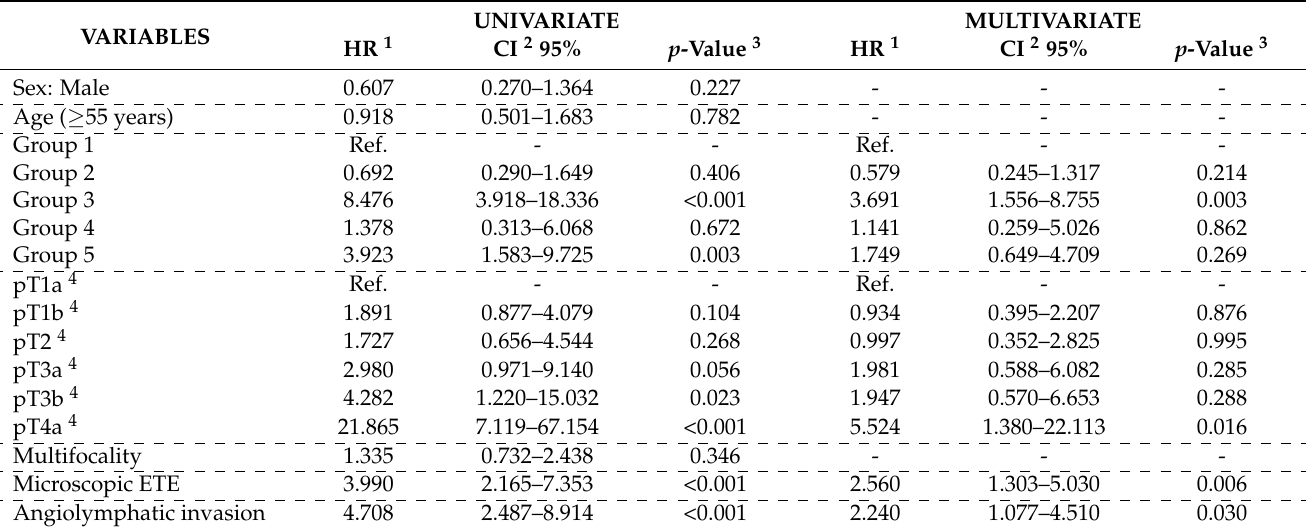
Table 5. Variables associated with worse disease-free survival in the univariate and multivariate